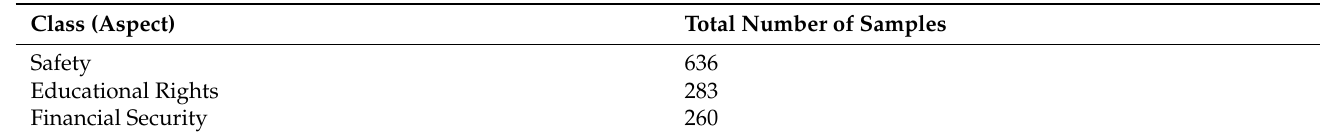
Table 7. Distribution of Emotional Triggers Training Dataset.